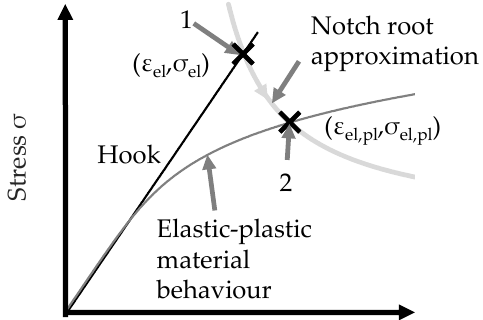
Figure 1. Estimation of local elastic-plastic stresses and strains from linear-elastic stresses using a notch root approximation (schematically).